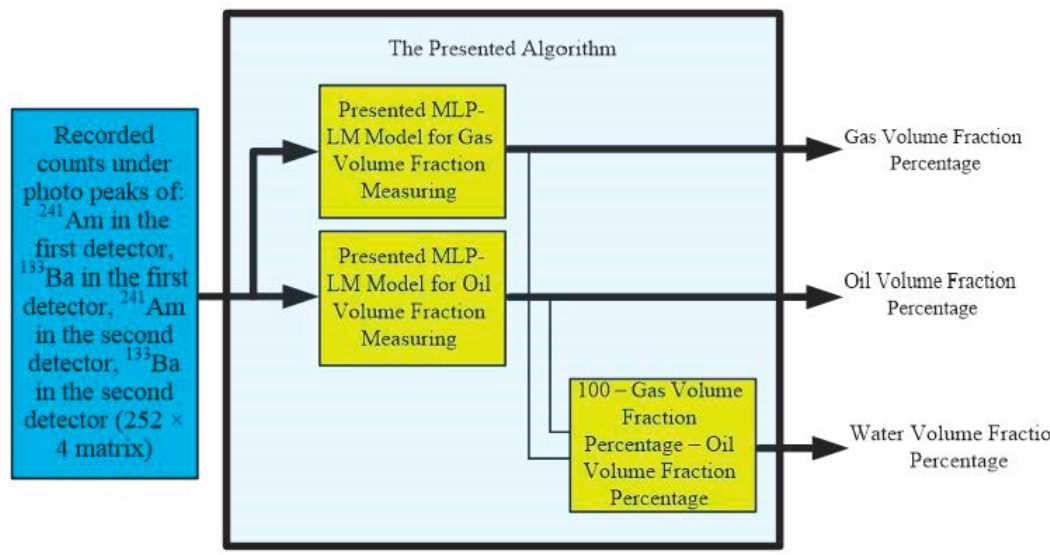
Figure 5. The procedure of obtaining gas, oil, and water volume fraction percentage in a three-phase flow independent of scale layer thickness.